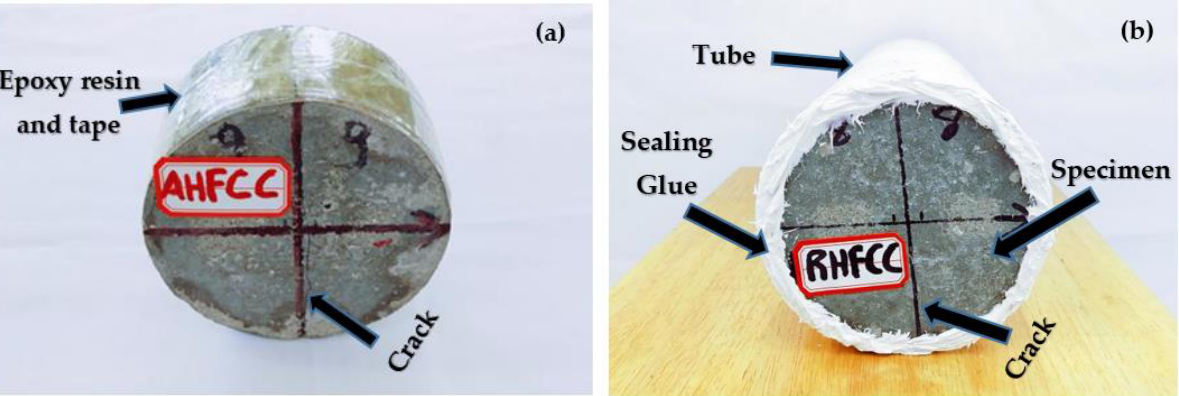
Figure 8. Specimen preparation for the permeability test: ( a ) a specimen’s lateral face sealing with epoxy resin and adhesive tape, ( b ) circumference’s sealing of the PVC tubes containing the specimen.